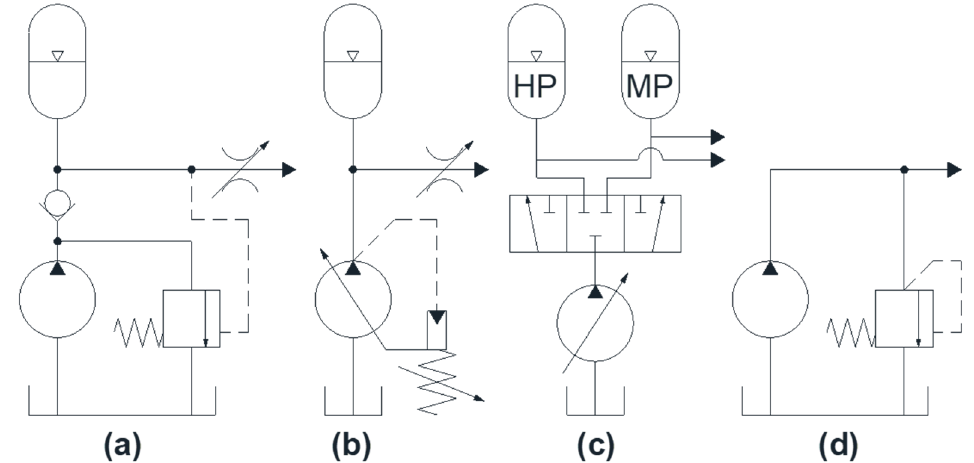
Figure 1. Four possible constant pressure systems: ( a ) Fixed displacement pump with accumulator, ( b ) Pressure compensated pump with accumulator, ( c ) Multiple pressure rail system, and ( d ) Fixed displacement pump at constant relief pressure.